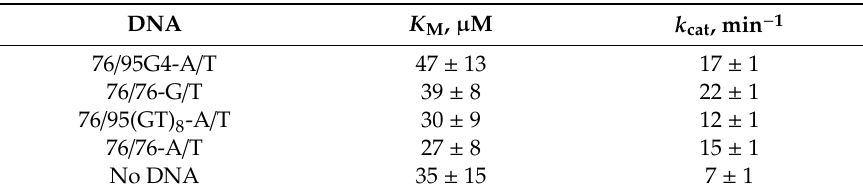
Table 3. Michaelis–Menten equation parameters for the ATP hydrolysis reaction by ecMutS in the presence of DNA